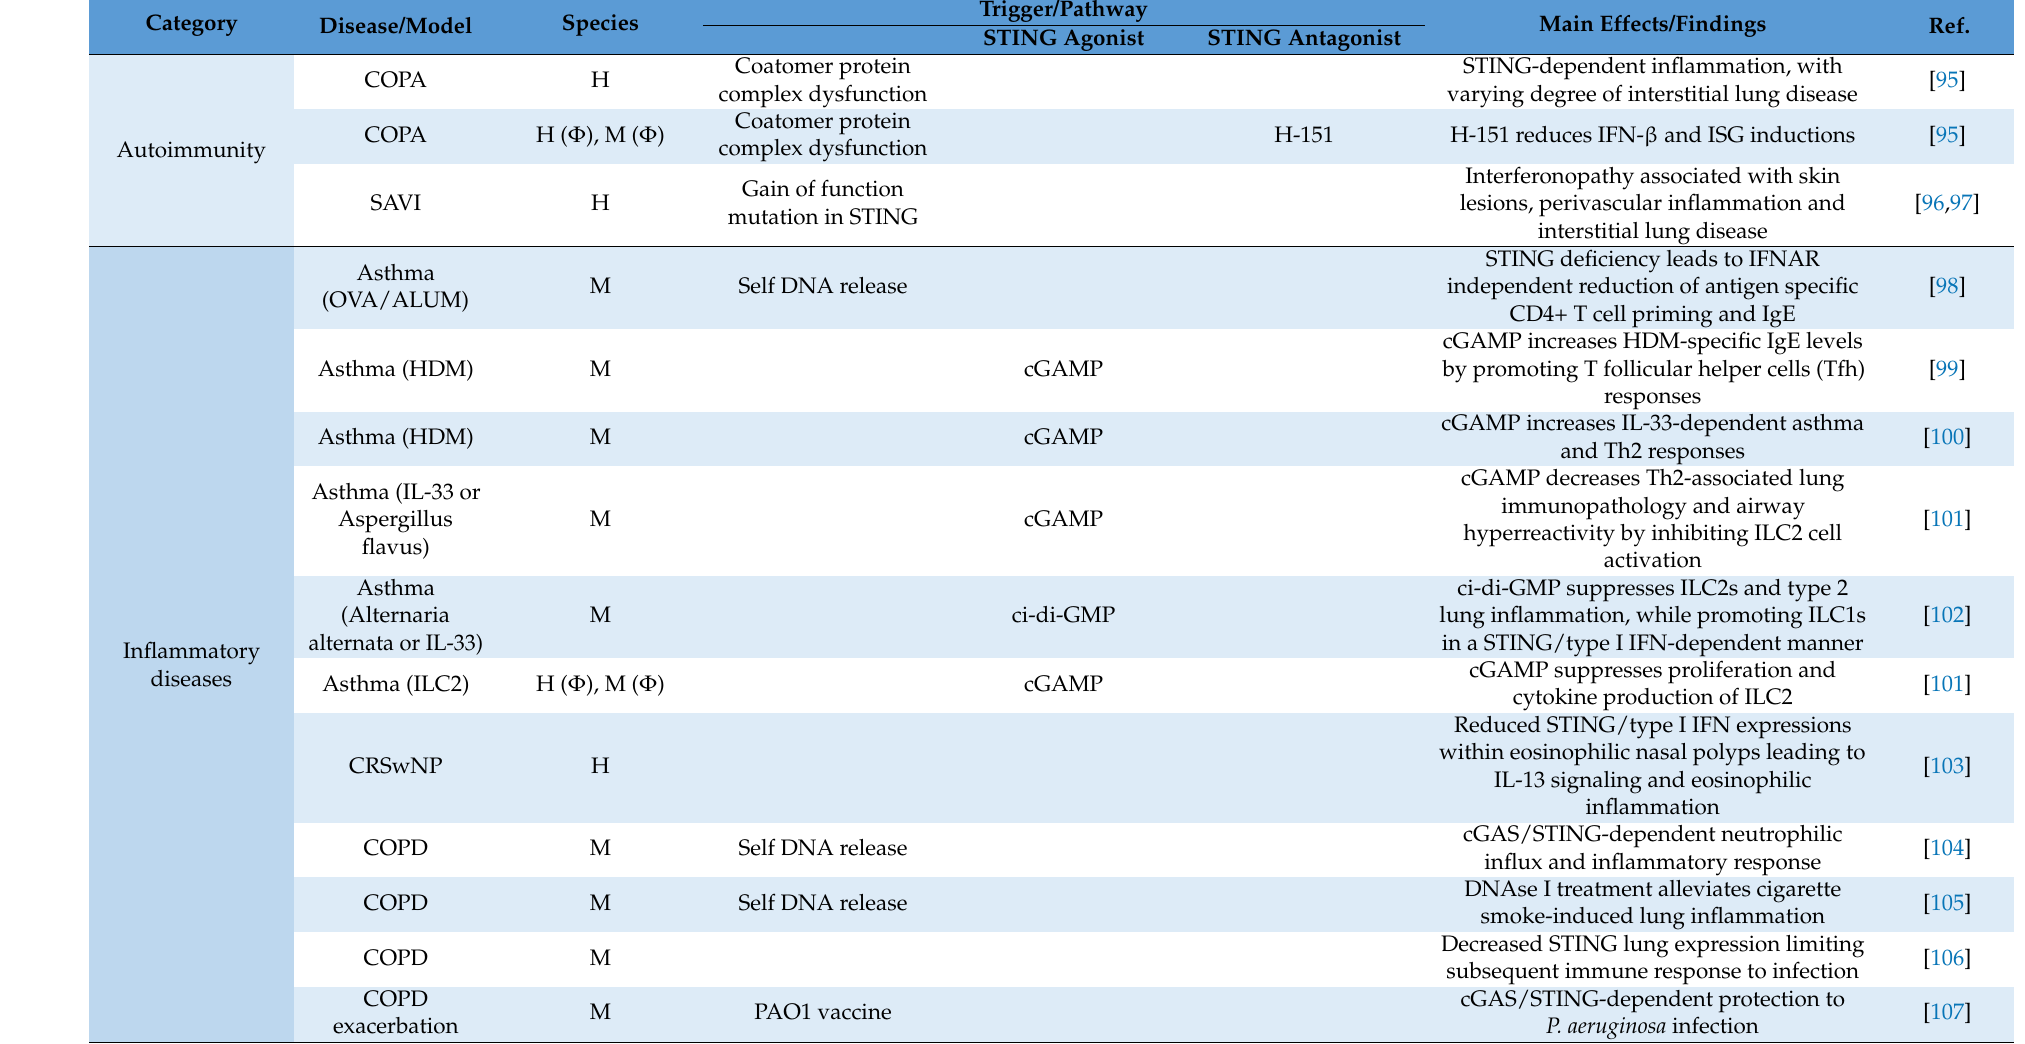
Table 2. Role of the STING pathway in lung